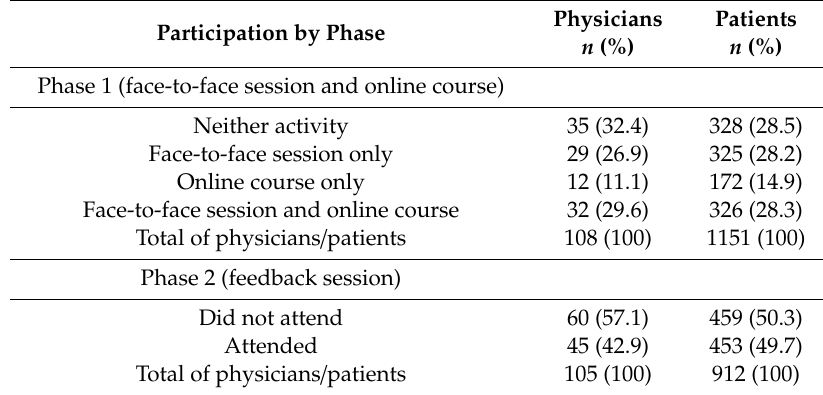
Table 1. Distribution of physicians’ participation in the phases of the clinical practice guidelines (CPG) implementation.